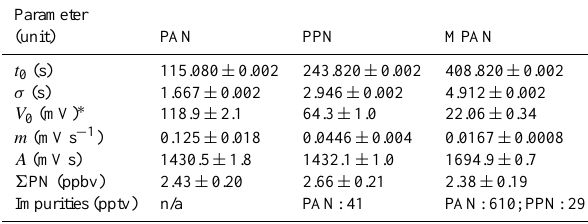
Table 2. Parameters of Eq. (1) fitted to the chromatograms in Fig. 5b, acquired during the FOSSILS 2013 field campaign. The fit uncertainties are those estimated using built-in algorithms in the Igor Pro 6 software package. The uncertainty stated for 6 PN is the 1 σ measurement